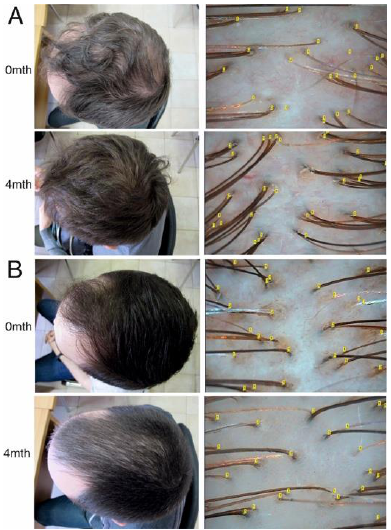
Figure 1. Global photos and trichograms assessment before and after 4 months of conservative treatment in androgenic alopecia (AGA) patients with a positive effect ( A ) and an absence of effect ( B ).